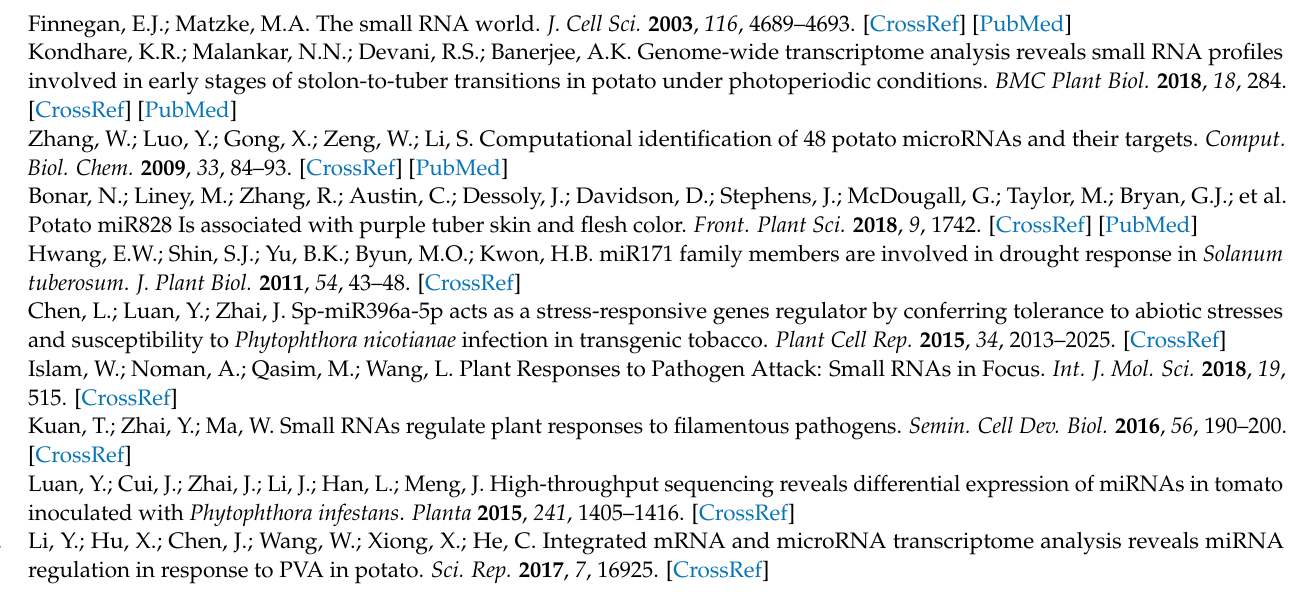
Table S1: Predicted miRNAs in potato and P. infestans ; Table S2: Predicted potato target genes of 171 potato miRNAs; Table S3: Predicted P. infestans target genes of 53 potato miRNAs; Table S4: Disease lesion phenotypes on leaves transient expressing miRNAs; Table S5: Primers used in this